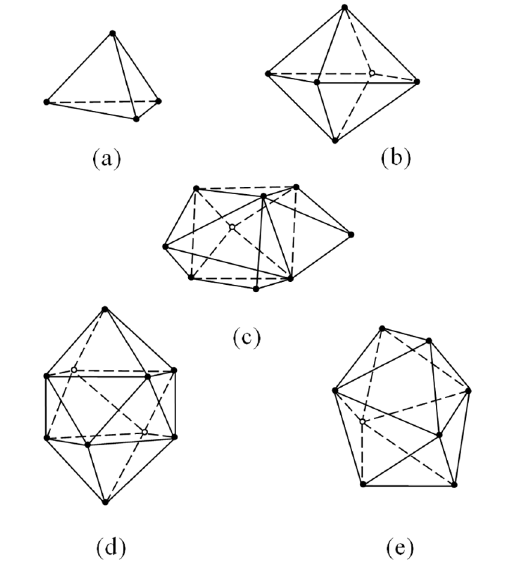
Figure 1. Five Bernal polyhedra: (a) Tetrahedron, (b) Octahedron; (c) Trigonal prism capped with three half octahedra; (d) Archimedean antiprism capped with two half octahedra; (e) Tetragonal dodecahedron.